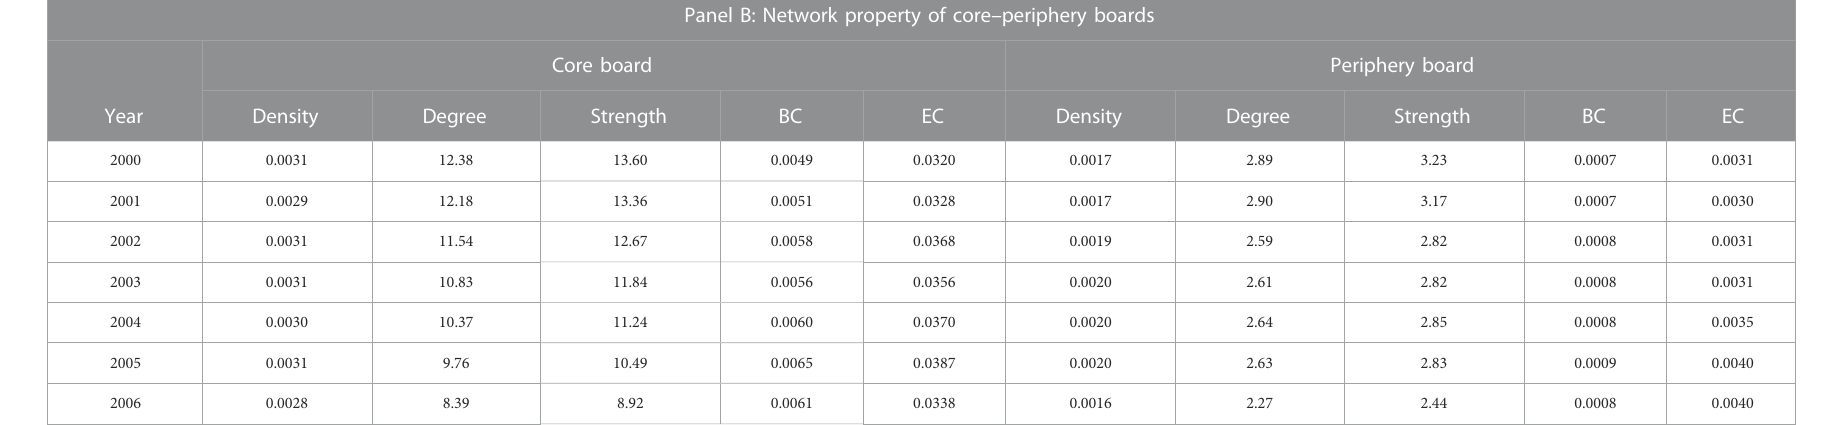
TABLE 2 Board network property over time.